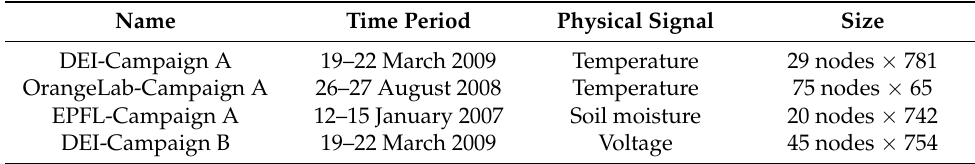
Table 2. Details of Datasets in 5G IoT Networks.